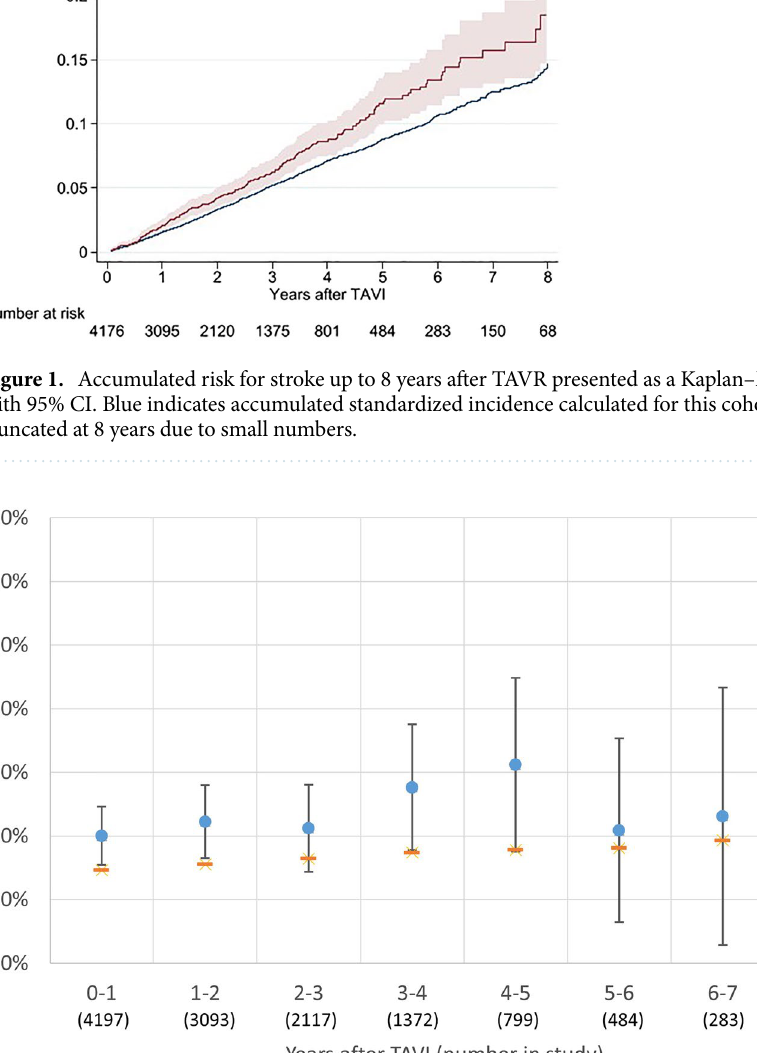
There was no difference between BEV/MEV and SEV in univariate analysis (HR 1.01 [0.78–1.30], p = 0.955). This variable was forced into the multivariable analysis and still reached significance. Of the 235 patients with stroke, 210 strokes were classified as ischemic stroke (IS), 24 were classified as hemor- rhagic stroke (HS), and one stroke was unable to be classified as ischemic or hemorrhagic. The stroke occurred on a median 20.6 (IQR 9.9–38.3) months after the TAVR procedure, with no significant difference between IS and HS (Table 2). Almost half of the patients (47.7%) had atrial fibrillation when they were admitted for their stroke, and no significant difference was seen between IS and ICH in rate of atrial fibrillation (46.7% vs 54.2%, p = 0.486). Consciousness at arrival was documented. While the majority (82.1%) were fully conscious, 5.1% were unconscious at arrival with an overrepresentation of HS compared to IS (25.0% vs 2.9%, p < 0.001), and 8.1% had a reduced consciousness, which also was seen more often in HS than IS (16.7 vs 7.1, p < 0.001). An additional 4.7% were not classified (Table 2). After the stroke, almost half of the patients (39.6%) could be discharged home, and patients with IS were more often discharged home than patients with HS (42.9% versus 12.5%, p < 0.001). The 30-day mortality for stroke was 19.6%, where IS had a better 30-day survival than HS (16.2% vs 45.8%,